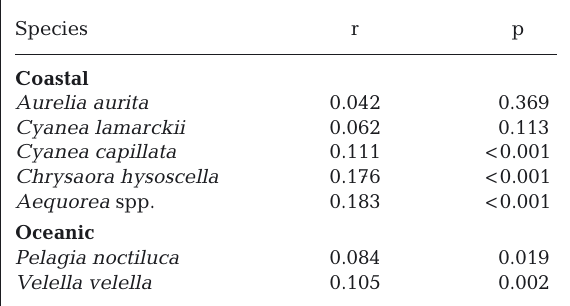
Table 2. Circular−linear correlation between jelly fish densi- ties and location; n = 564 for all